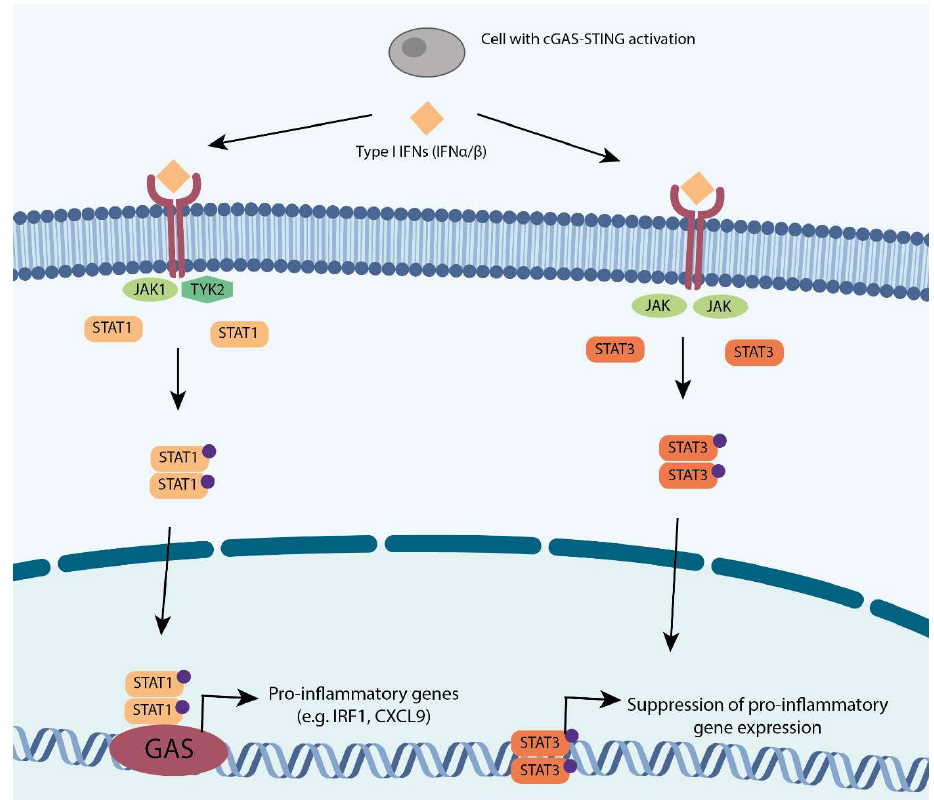
activate JAK1-TYK2 receptors which in turn phosphorylate STAT1, causing its dimerisation. STAT1 dimers travel to the nucleus to drive pro-inflammatory genes. The STAT3 branch: The same substrates also activate JAK-JAK receptors that in turn phosphorylate STAT3 catalyzing its dimerisation. STAT3 dimers translocate to the nucleus to suppress of pro-inflammatory genes. Phospho-groups are indicated in